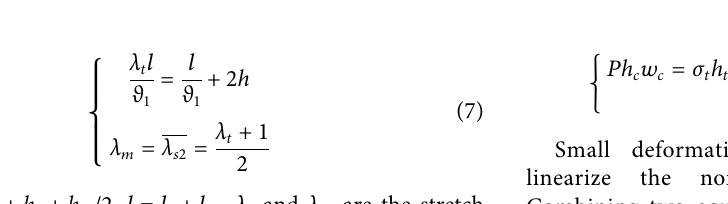
Frontiers in Mechanical Engineering |